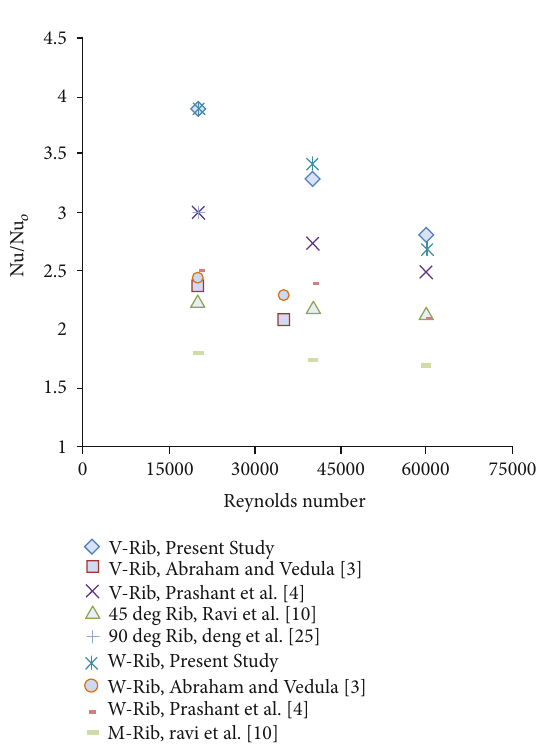
Figure 12: Comparison of Nu/Nu